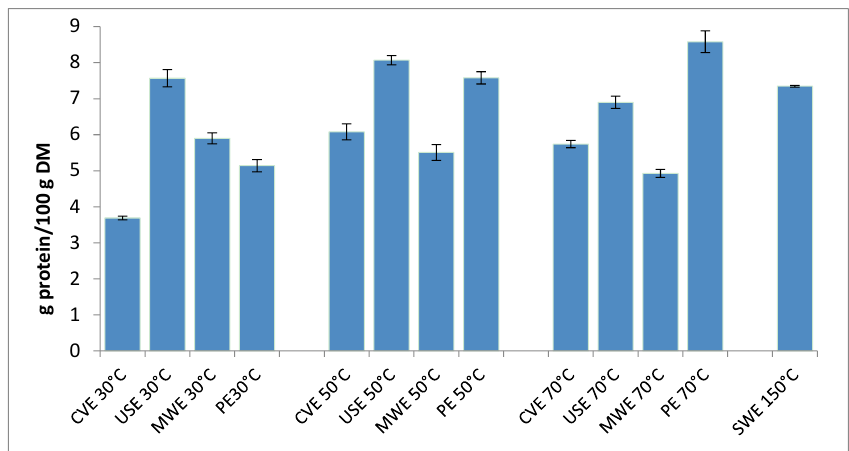
Figure 1. Protein yield profiles as a function of temperature.